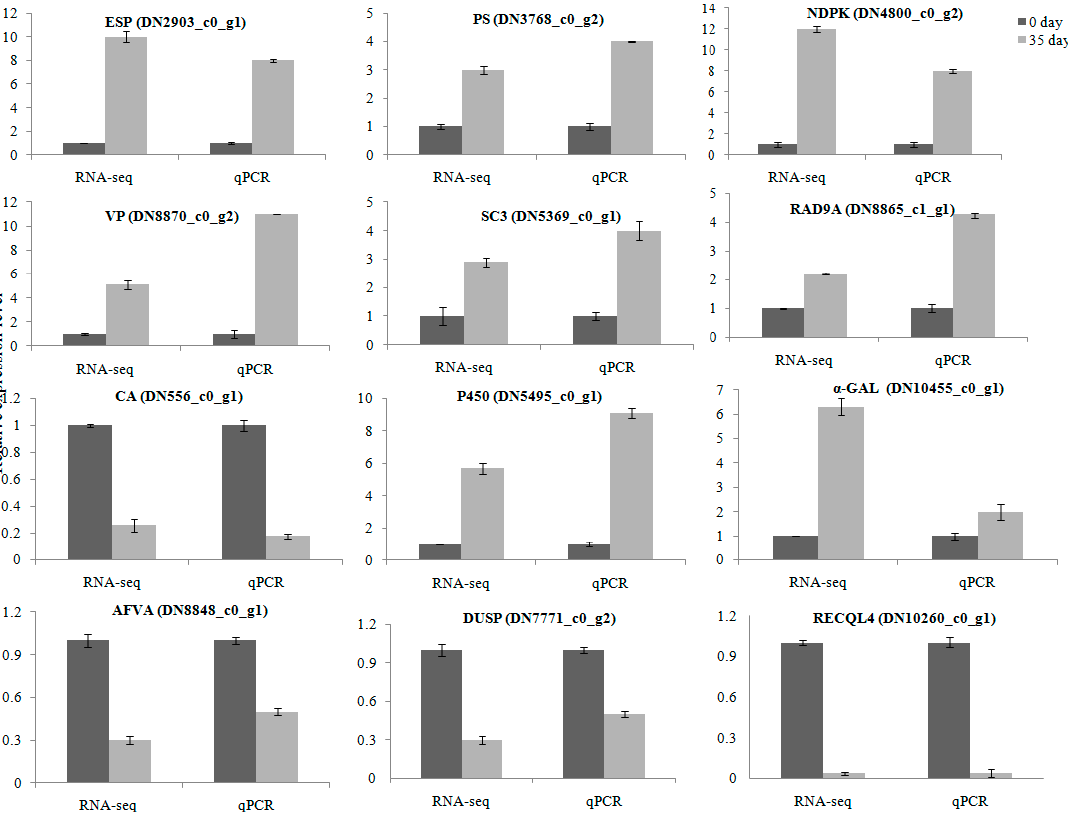
Figure 8. Expression of 12 selected genes as determined by RT-qPCR in comparison to the RNA-seq results. Gapdh expression was used as the internal control. The RT-qPCR values for each gene are means ± SD of three biological replica.